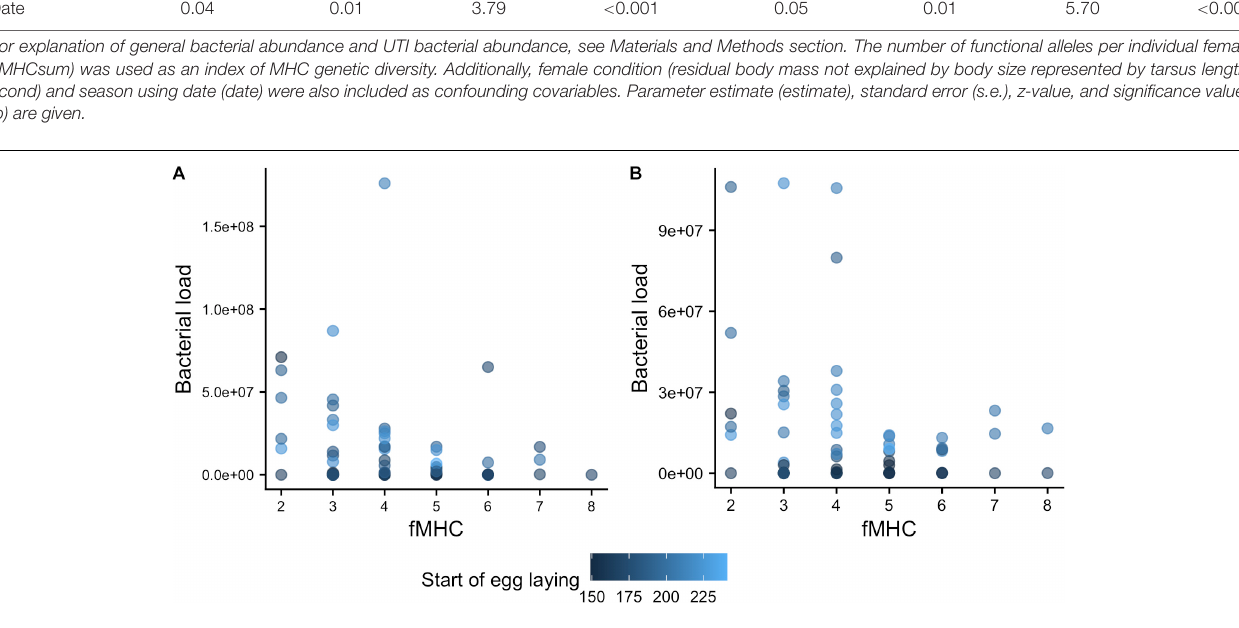
FIGURE 1 | Relationship of general bacterial (A) and UTI bacterial abundance (B) with the number of functional alleles per individual female (fMHCsum) which is an index of MHC genetic diversity. The color gradient represents the start of egg laying (a day from the beginning of the calendar year) of a particular female ranging from gray at the beginning of the breeding season to light blue at the